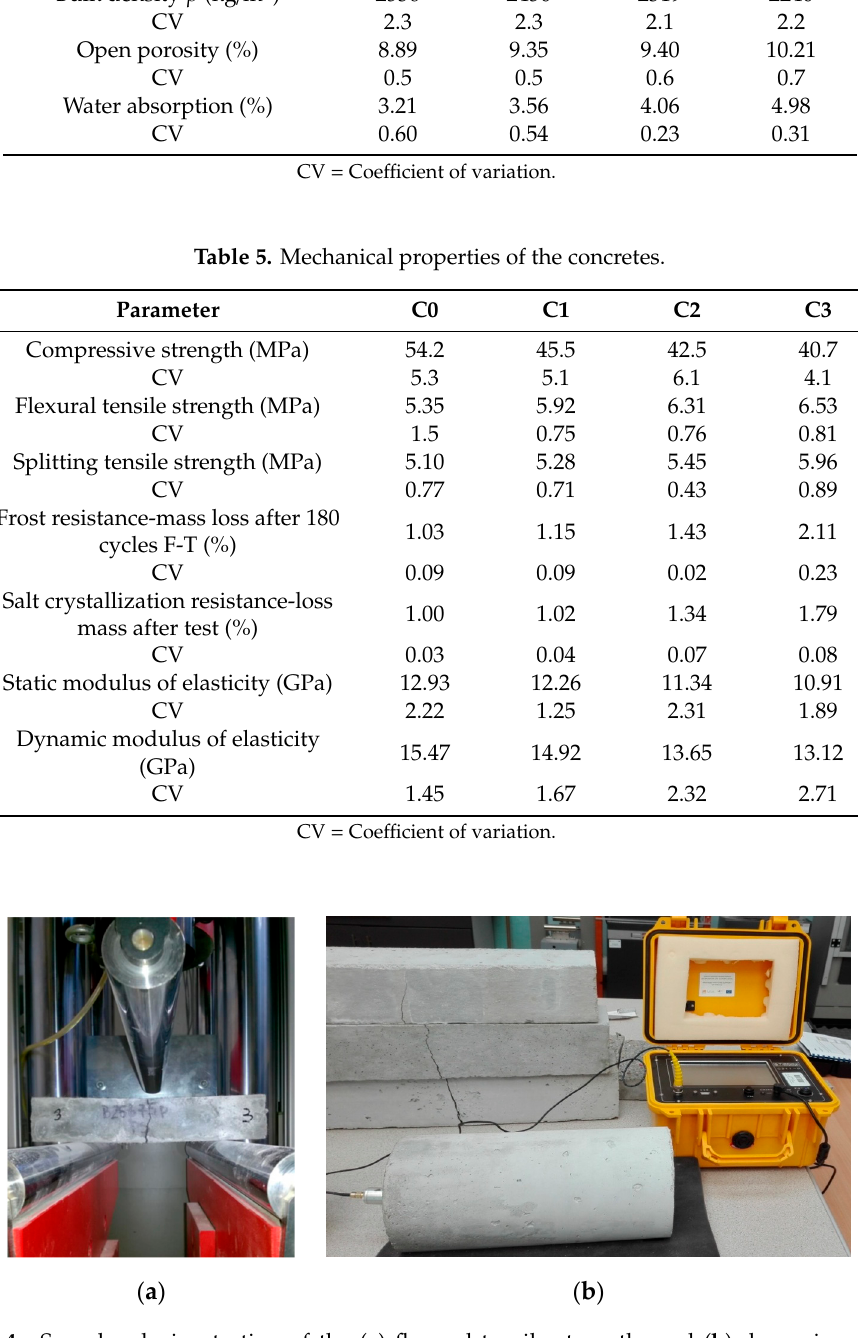
Figure 4. Samples during testing of the ( a ) flexural tensile strength; and ( b ) dynamic modulus of elasticity.